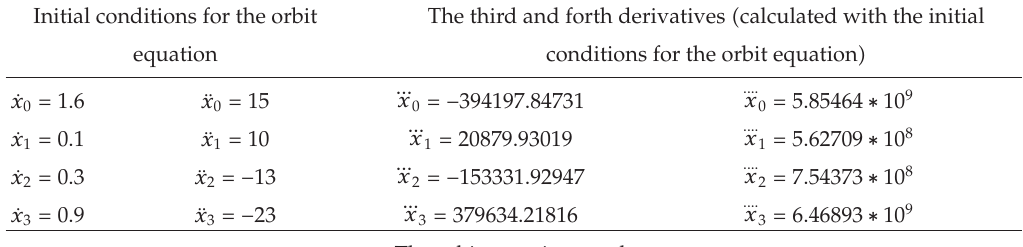
Table 1: First set. The parameters: μ (cid:3) 3 ∗ 10 − 3 GeV − 1 , Mα (cid:3) 4 . 84473 ∗ 10 5 GeV 2 .